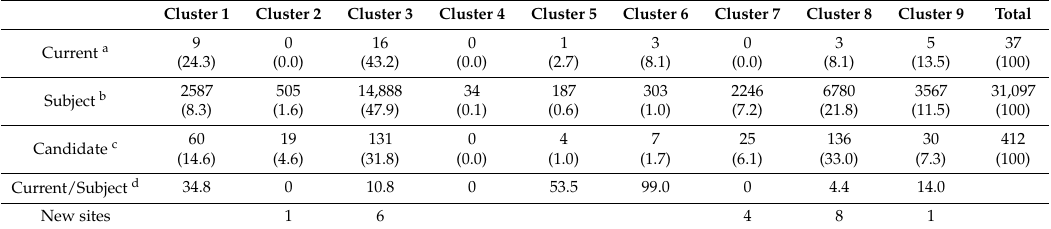
Table 2. Numbers (%) of subject, current, and candidate locations, proportions of current to subject locations, and numbers of new selected sites across nine clusters for PM 2.5 .